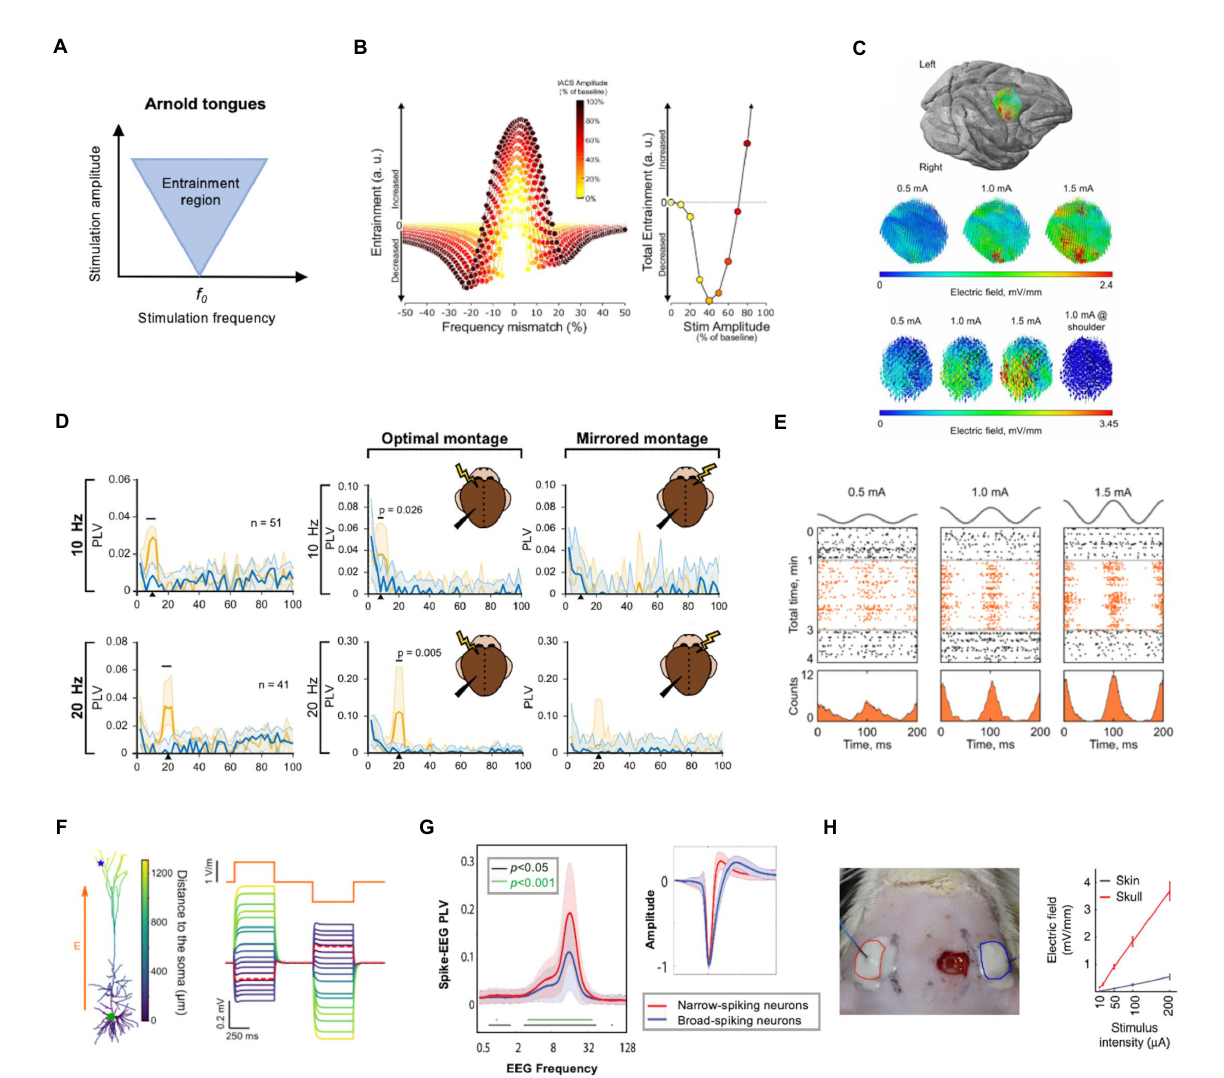
FIGURE 1 Neurophysiological mechanisms and essential factors for tACS. (A) Illustration of Arnold tongue. The inverted triangle shapes the possible stimulation amplitude and frequency parameter combinations. (B) The entrainment changes at different combinations of frequency mismatch and stimulation intensity (left) and total entrainment are calculated by integrating the left curves within 2 Hz bins (right). It is illustrated that enhanced oscillation occurs when the stimulation frequency closely matches the endogenous oscillation; however, even a minor mismatch can result in decreased oscillation when the stimulation amplitude is relatively weak. (C) Electrical field intensity distribution in one monkey on the target brain area. The field distributions had the same orientation and relative spatial relationships as the intensity increased linearly from 0.5 to 1.5 mA. (D) Phase-locking value (PLV) spectra of target neurons during tACS at 10 and 20 Hz during sham (blue line) and active tACS duration (orange line). The tACS effects of target neurons are specific to the stimulation frequency (left column) and location (right column). Only around the stimulation frequency did neural entrainment occur at each frequency (horizontal black lines indicate significant bands). Furthermore, when compared to the contralateral side, tACS on the ipsilateral side of signal recording showed significant entrainment. (E) tACS-induced entrainment of one representative neuron from an awake monkey at 0.5, 1, and 1.5 mA intensities. The spike rate (lower row) and time course (upper row: black dots for pre − /post-stimulation duration, orange dots for stimulation duration) revealed an increase in neuron spikes and clustering to the peak of the sine wave as the intensity increased during the stimulation period, indicating a dose-dependent manner. (F) Electric field sensitivity in a passive pyramidal cell model (the blue star represents the apical dendrites, and the green circle represents the soma). The orange line represents the stimulation current. The figure depicts how the induced field differed from neuron morphology. (G) The synchrony between network-scale oscillations and interneurons varies according to neuron type. Right: Two types of neurons were identified based on spike characteristics: narrow-spiking (red line) neurons and broad-spiking neurons (blue line). Narrow-spiking neurons had higher PLV than broad-spiking neurons. (H) A diagram of transcutaneous stimulation in rodent research (left) and a comparison of the electric field values of transcutaneous and subcutaneous stimulations at the same stimulus intensities (right). The field value is heavily influenced by the stimulation pattern. Subfigures B, C, D, E, F, G and H have been adapted with the authors’ and publisher’